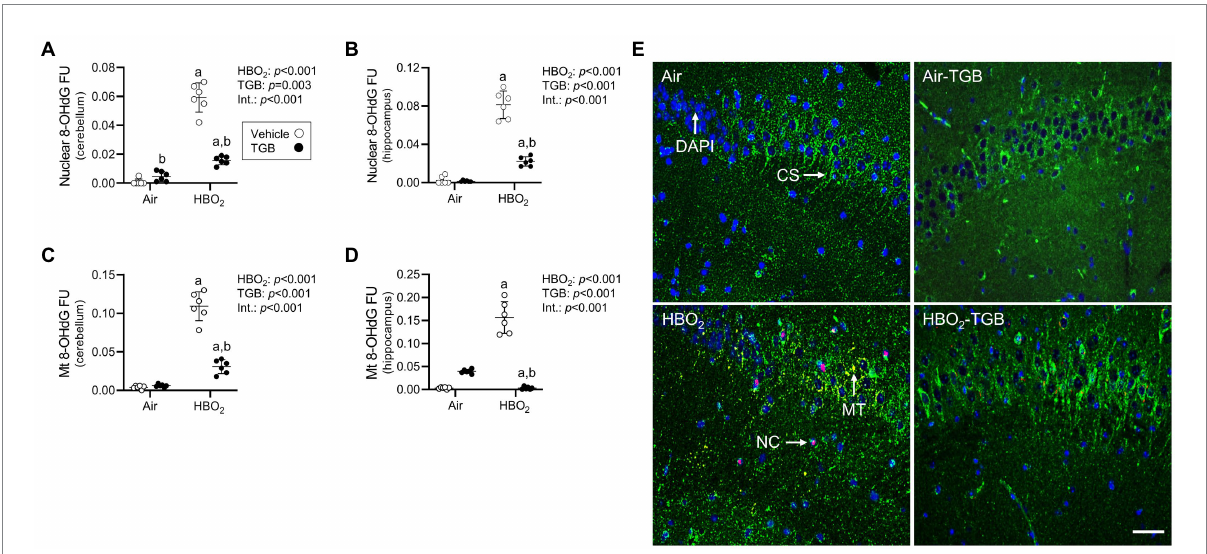
FIGURE 2 Nuclear and mitochondrial DNA oxidation in mice exposed to extreme HBO 2 . Mice were pretreated with 0.9% NaCl or TGB (4.8 mg/kg body weight) 30 min before exposure to air or 5 ATA oxygen for 30 min. (A–D) Quantification of nuclear and mitochondrial 8-OHdG in the cerebellum and hippocampus. (E) Representative images from the hippocampus. 8-OHdG (red), citrate synthase (CS, green), and DAPI (blue). 8-OHdG merged with DAPI indicates nuclear oxidation (NC). 8-OHdG merged with citrate synthase indicates mitochondrial oxidation (MT). Scale bar = 100 μ m. Main effect of a HBO 2 and b TGB, p <